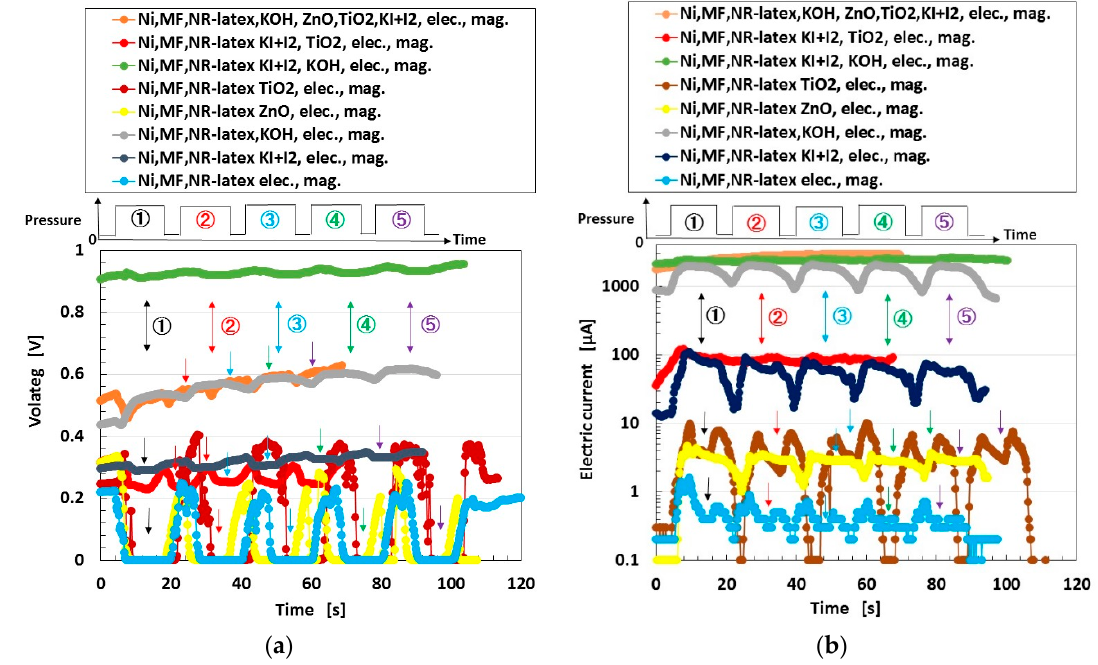
Figure 13. Change in voltage and electric current under five-times from ① to ⑤ repeated compression for MCF rubber electrolytically polymerized under a magnetic field: ( a ) voltage; ( b ) current density.